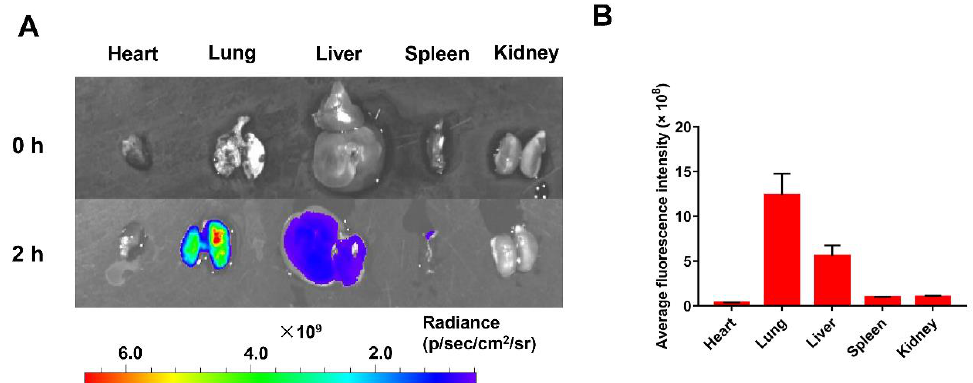
Figure 4. In Vivo distribution of nanoparticles. ( A ) Fluorescence intensity images of main organs of mice after intravenous injection of Cy5-linked TPT@CL-MOF at 2 h. ( B ) Average fluorescence intensity of main organs after 2 h of intravenous injection ( n = 3).